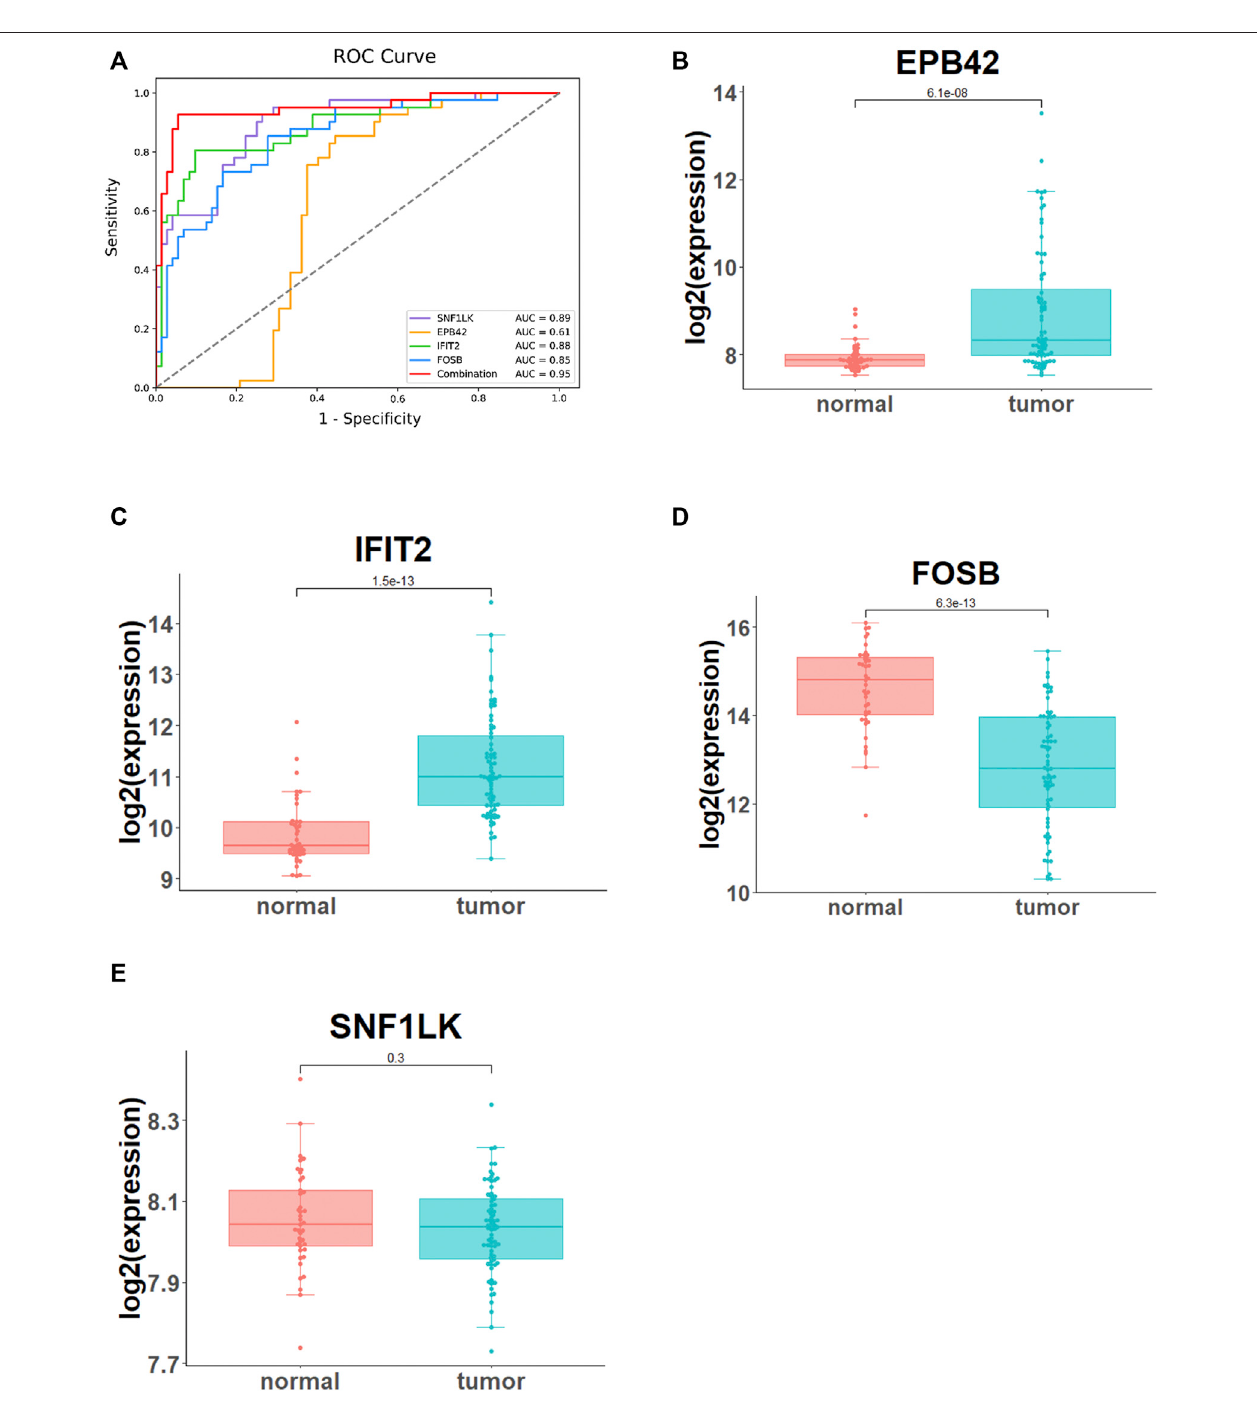
FIGURE 4 | Analyses of ROC and optimal feature gene expression. (A) The diagnostic performance of the four optimal feature genes alone and their combination evaluated by ROC analysis. (B – E) The expression differences in EPB42, IFIT2, FOSB, and SNF1LK in GSE33463 between normal samples and PAH samples.